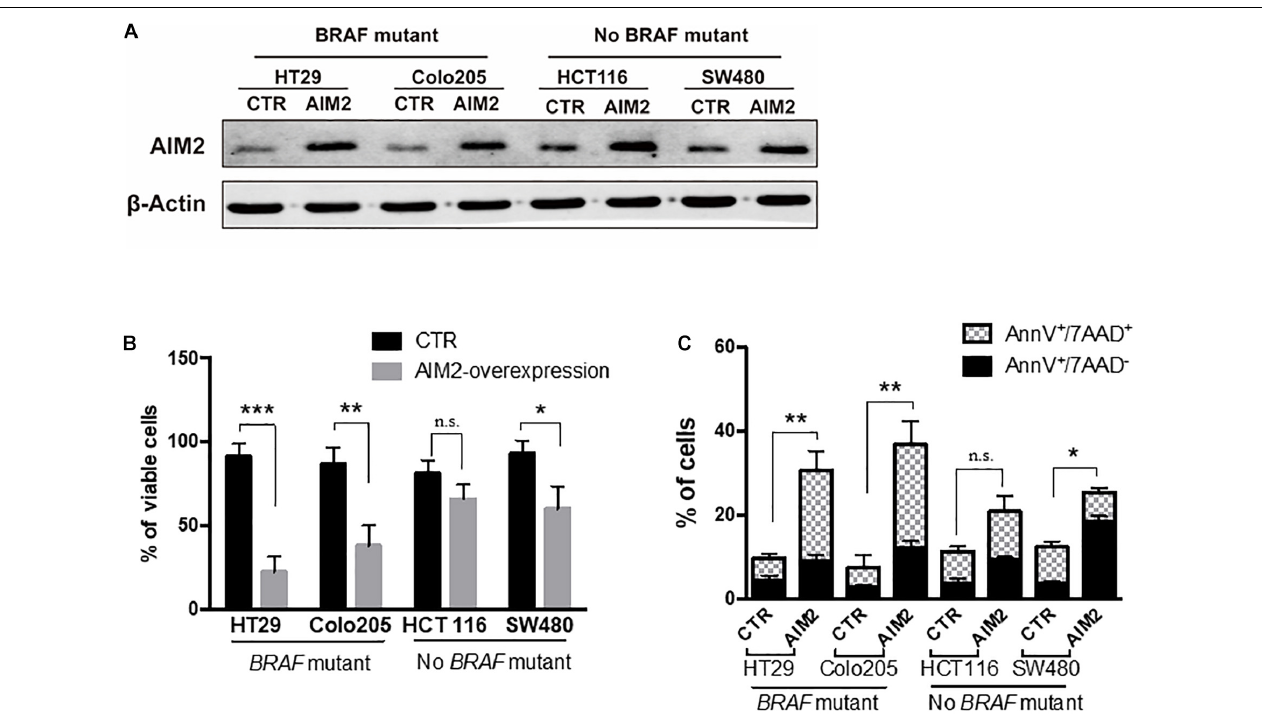
FIGURE 2 | Restoration of AIM2 expression inhibits the growth of BRAF-mutant CRC cells. (A) The efficiency of plasmids transfection in human CRC cell lines (HT29, Colo205, HCT116, and SW480) was determined by Western blotting 2 days after transfection. (B) Cell viability assay was performed to evaluate the proliferation of human CRC cells after transfection of overexpressed AIM2 plasmid or control vector ( n = 3, Student’s t -test). (C) Annexin V/7-AAD staining and flow cytometry analysis were performed to investigate the type of cell death in human CRC cells after transfection of overexpressed AIM2 plasmid ( n = 3, χ 2 test t ). * p < 0.05, ** p < 0.01, *** p <